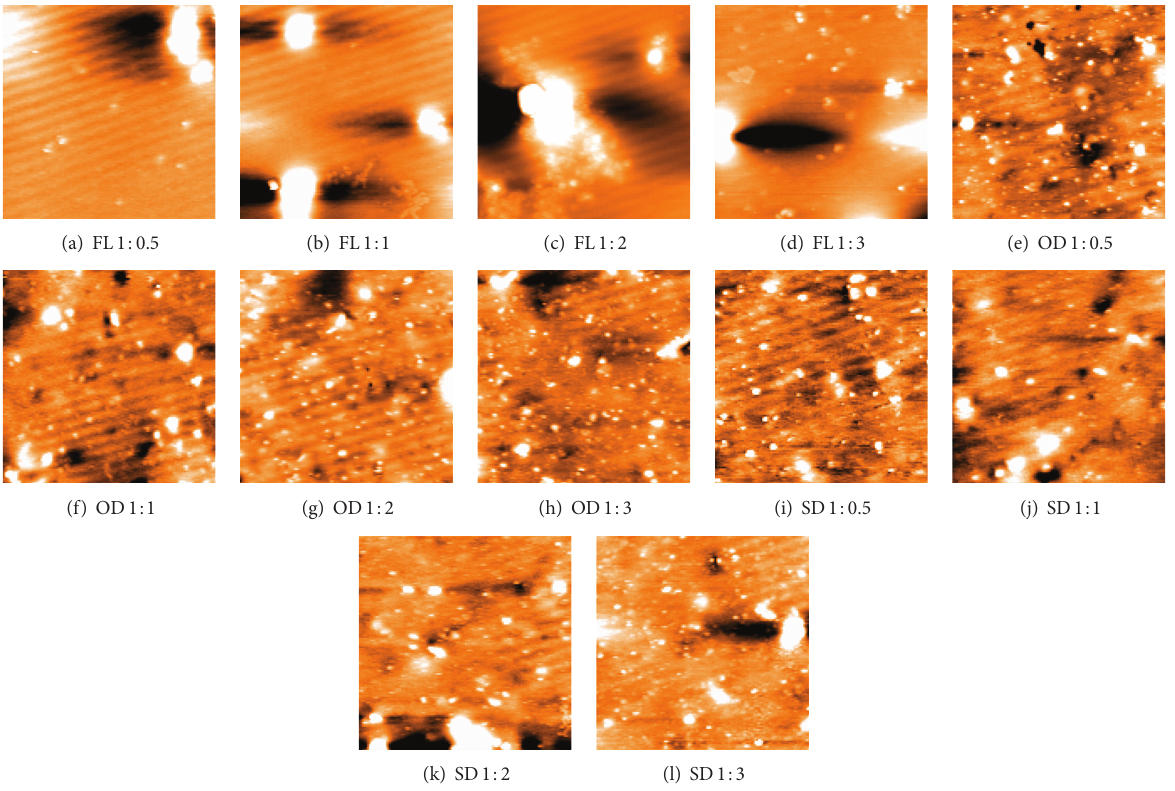
Figure 4: AFM micrographs of silver nanoparticles synthesized from the leaf extracts of Pimenta dioica : (a) fresh leaves in 1:0.5 ratio with silver nitrate, (a) fresh leaves in 1:1 ratio with silver nitrate, (a) fresh leaves in 1:2 ratio with silver nitrate, and (a) fresh leaves in 1:3 ratio with silver nitrate; (b) sun-dried leaves in 1:0.5 ratio with silver nitrate, (b) sun-dried leaves in 1: 1 ratio with silver nitrate, (b) sun-dried leaves in 1:2 ratio with silver nitrate, and (b) sun-dried leaves in 1:3 ratio with silver nitrate (c) hot-air oven dried leaves in 1: 0.5 ratio with silver nitrate (c) hot-air oven dried leaves in 1: 1 ratio with silver nitrate; (c) hot-air oven dried leaves in 1:2 ratio with silver nitrate and (c) hot-air oven dried leaves in 1: 3 ratio with silver